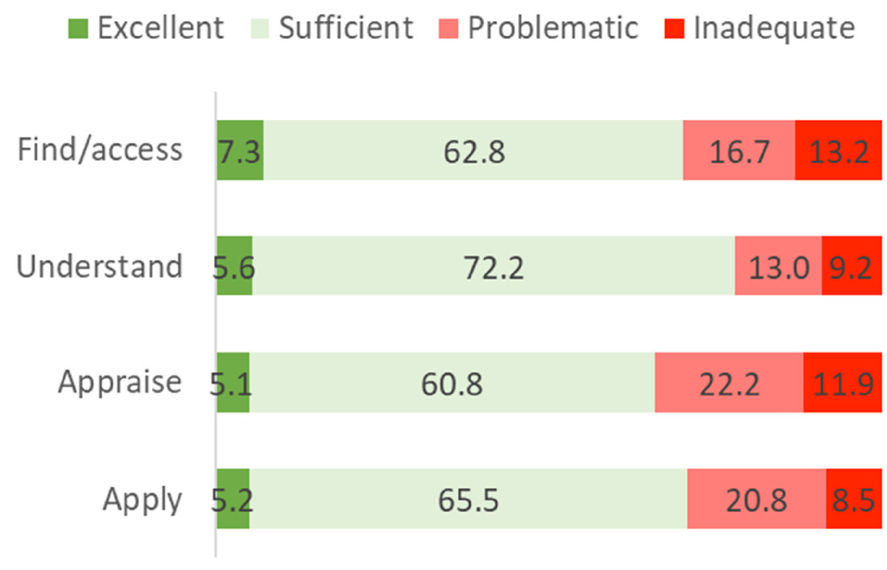
Figure 3. Processing health ‐ related information.